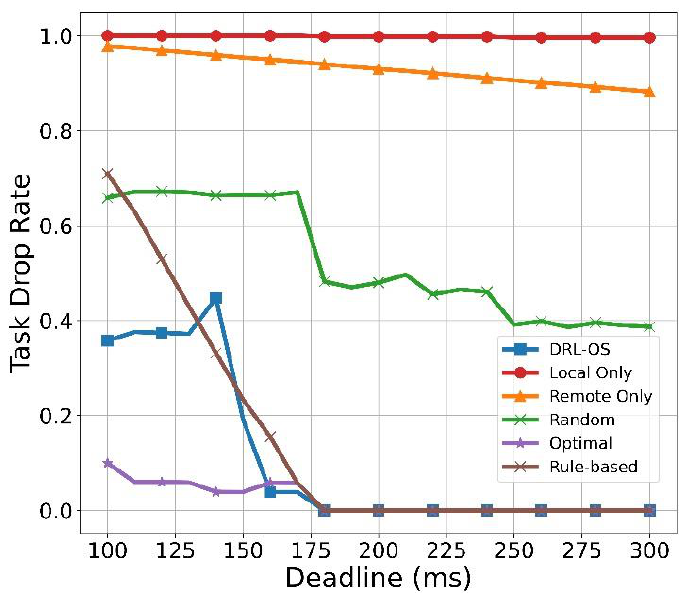
Figure 14. Task drop rate vs. deadline.